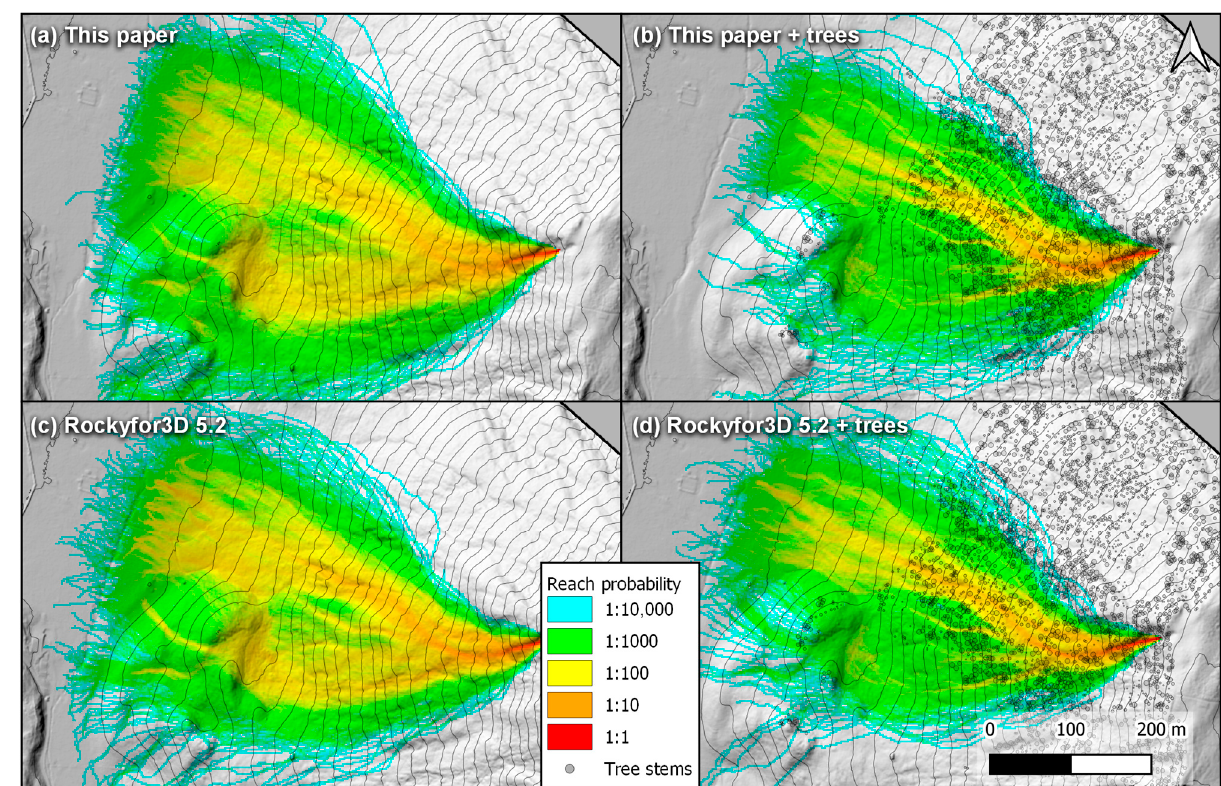
Figure 24. Results for the comparison on the alpine slope near La Verda–Rougemont in Switzerland. The left windows ( a , c ) show the reach probability results from the proposed algorithm compared to those from Rockyfor3D 5.2.15. The right windows ( b , d ) show the same results, but with tree stems considered. The colors are based on a log10 distribution to show the changes in order of magnitude instead of linearly, which enhances the subtle changes in the low reach probability values. The 10 m contour lines and hill shade base layers are from a 1 m cell size gridded DTM.